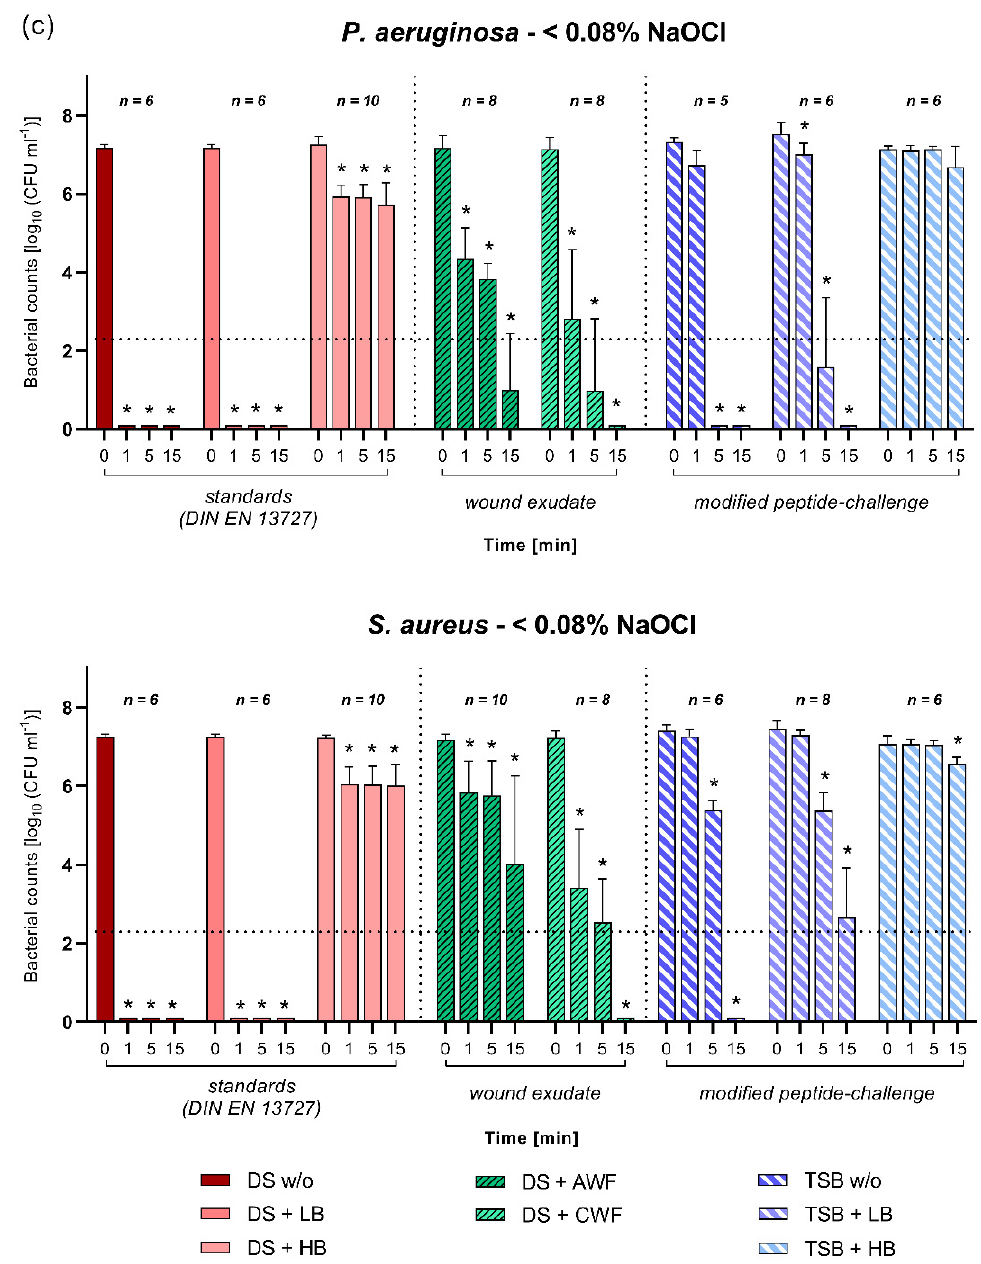
Figure 3. ( a – c ) Antimicrobial efficacy of hypochlorous wound irrigation solutions against P. aeruginosa and S. aureus . Three different hypochlorous formulations were tested: ( a ) <0.005% NaOCl/HOCl, ( b ) 0.2% NaOCl/SS, and ( c ) <0.08% NaOCl. Bacterial survival rates (in log 10 CFU/mL) after 1, 5, and 15 min of exposure time under various challenge conditions and initial bacterial counts (0 min) are displayed. First section shows the standard DIN-EN-13727 conditions of no burden (DS w/o), low burden (DS + LB), and high burden (DS + HB) prepared in regular dilution solution (DS). Second section shows results when challenged with simulated wound conditions using human acute (DS + AWF) or chronic (DS + CWF) wound exudate in DS. Third section shows results for the modified peptide-challenge prepared in tryptone soy broth (TSB) with no burden (TSB w/o), low burden (TSB + LB), and high burden (TSB + HB). Values are expressed as mean ± SD (* p ≤ 0.05 vs. 0 min) and the dotted line represents a reduction in 5 log 10 cfu/mL steps compared to initial bacterial counts.